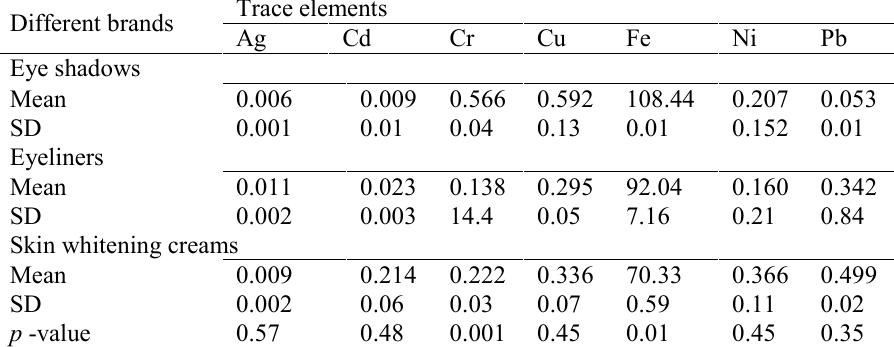
Table 1. Concentration of trace elements (µg/g) in different brands of cosmetic products